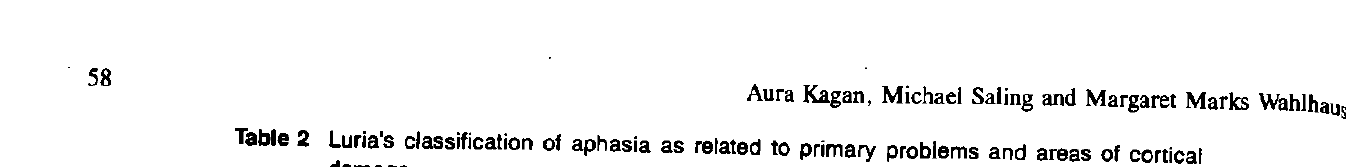
Table 2 Luria's classification of aphasia as related to primary problems and areas of cortical